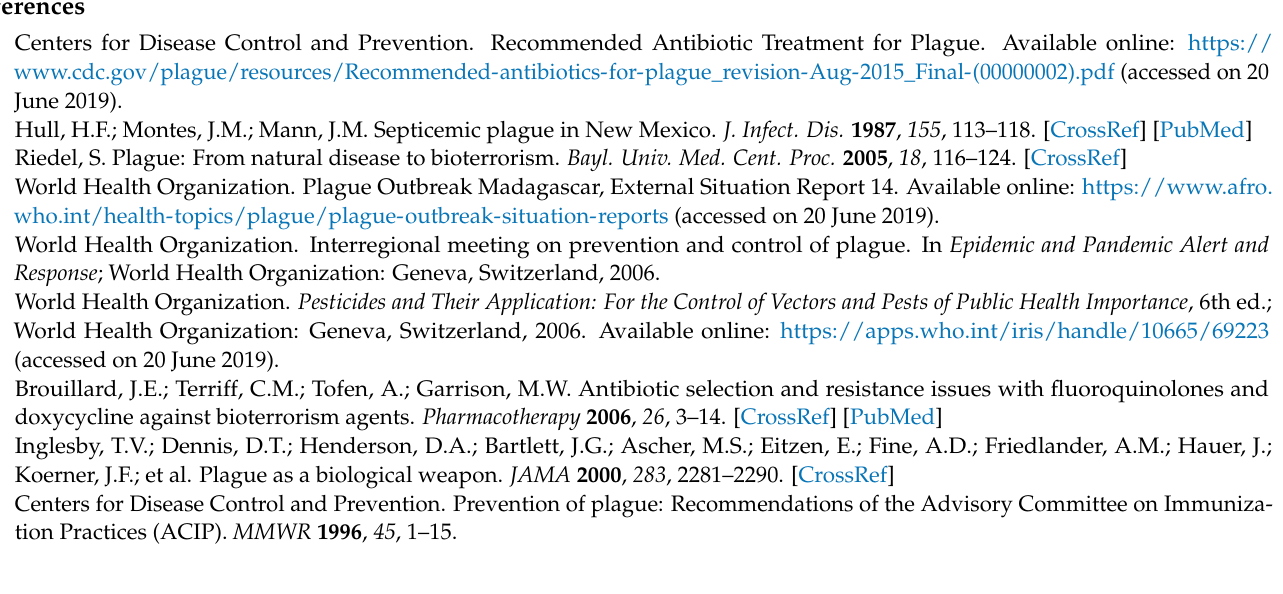
implementation timing. The interventions plotted include only those which have one intervention type, Figure S2: Intervention costs as a function of implementation timing and coverage, Figure S3: Sensitivity analysis on QALYs lost per death for cost-effective and very cost-effective interventions, Figure S4: Sensitivity analysis on the administrative cost per person of mass prophylaxis distribution program for cost-effective and very cost-effective interventions, Figure S5: Cost-effectiveness frontier when decision is restricted to interventions day 40 or later where coverage of additional antibiotic treatment is 80% or less and coverage of mass distribution of doxycycline prophylaxis or of malathion is 80% or less, Figure S6. In sensitivity analysis, we developed a model of an outbreak that spreads more slowly than the actual 2017 outbreak, Figure S7. Cost-effectiveness frontier for slower epidemic, Figure S8: SEIR compartmental model for human plague transmission showing transition parameters, Table S1: Calibrated Model Projections Compared to WHO Situation Reports, Percent Difference from Adjusted WHO Values, Table S2: Costs and Effectiveness of Cost-Effective Interventions for Different Intervention Implementation Days, Table S3: Costs and Effectiveness of Interventions on the Cost-Effectiveness Frontier for Different QALY Loss per Death, Table S4: Costs and Effectiveness of Interventions on the Cost-Effectiveness Frontier for Different Administrative Cost per Person of Mass Distribution, Table S5: Costs and Effectiveness of Interventions on the Cost-Effectiveness Frontier for a Slower Epidemic, detailed description of dynamic transmission model, description of calculation of health-related quality of life, description of sensitivity analyses with slower epidemic model, CHEERS